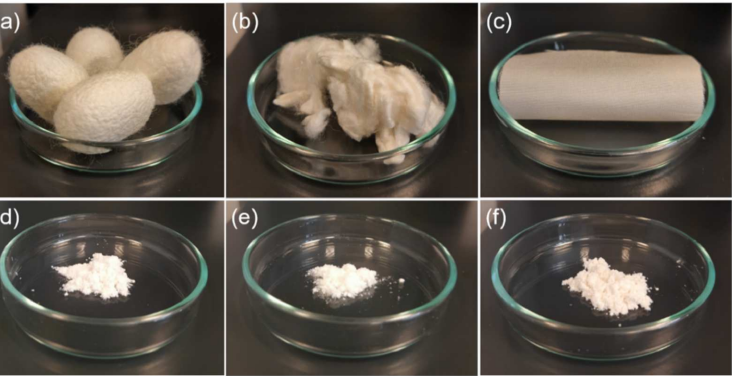
Figure 2. ( a ) Raw and ( b ) degummed silk cocoons, ( c ) silk fabric, and silk powders from ( d ) raw cocoons, ( e ) degummed cocoons, and ( f ) silk